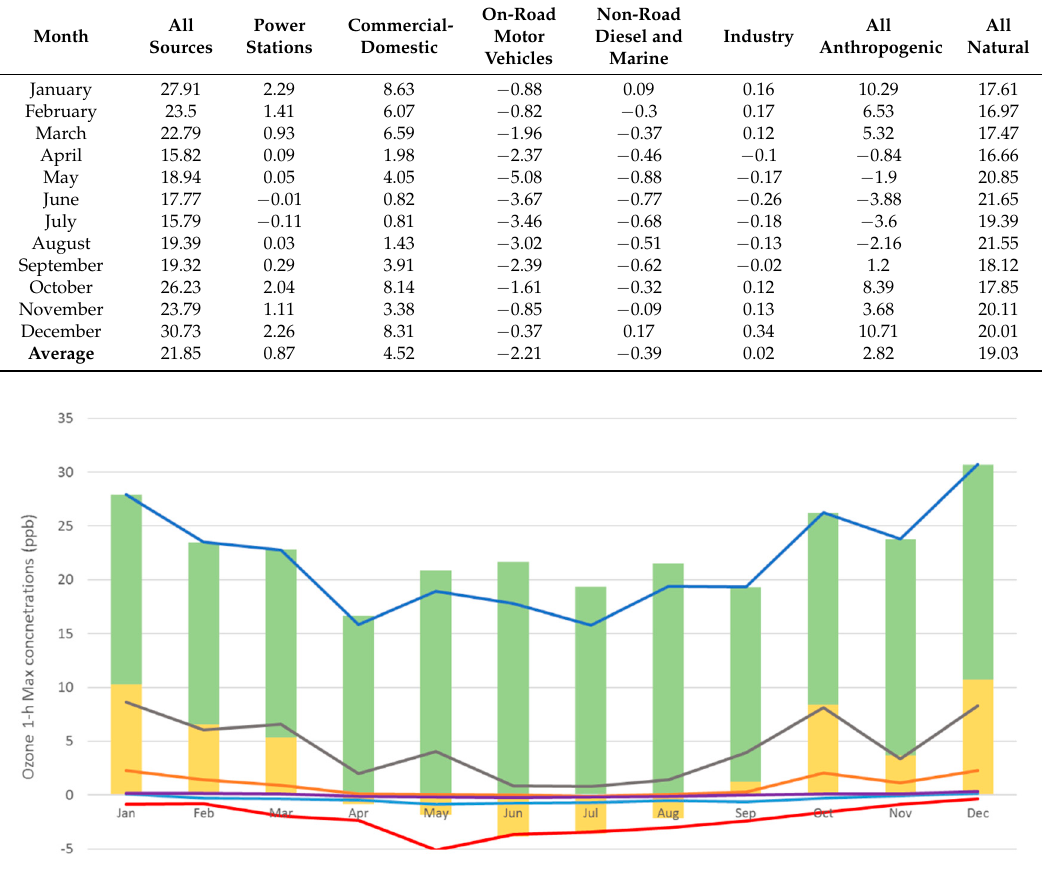
Table A3. Monthly average of daily maximum 1-h predicted ozone concentration (ppb) in the Sydney east region for different months in 2008 under various emission scenarios.